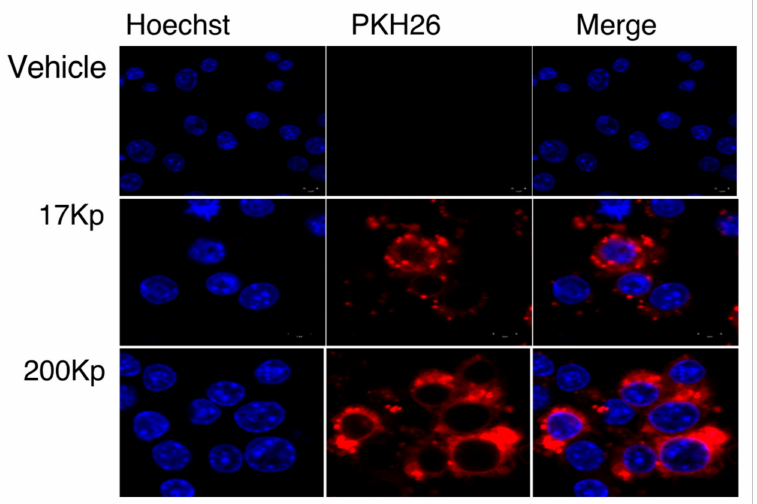
Figure 3. Intracellular incorporation of 17 Kp and 200 Kp into RAW264 cells. The 17 Kp or 200 Kp were stained with PKH26. Cells were treated with 400 µ g protein/mL 17 Kp or 200 Kp for 2 h. Then, the nuclei were stained with Hoechst33342. Cells were observed by confocal laser microscope. 2.4. Effect Endocytosis Inhibitors on PKH26 Stained 17 Kp and 200 Kp Uptake